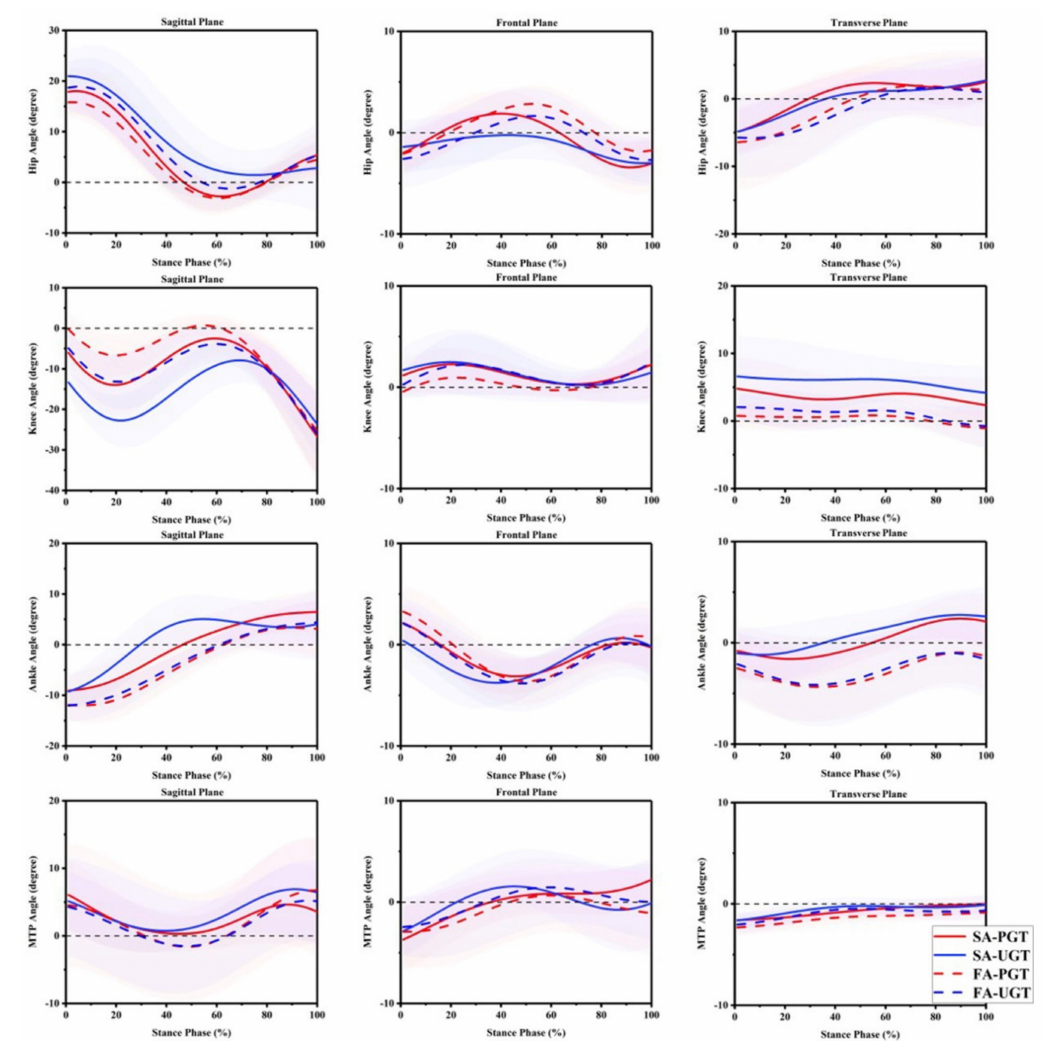
Figure 2. Joint angles curves of the hip, knee, ankle, and metatarsophalangeal (MTP) joints in sagittal, frontal, and transverse planes during gait terminations. SA: stiff arch; FA: flexible arch; PGT: planned gait termination; UGT: unplanned gait